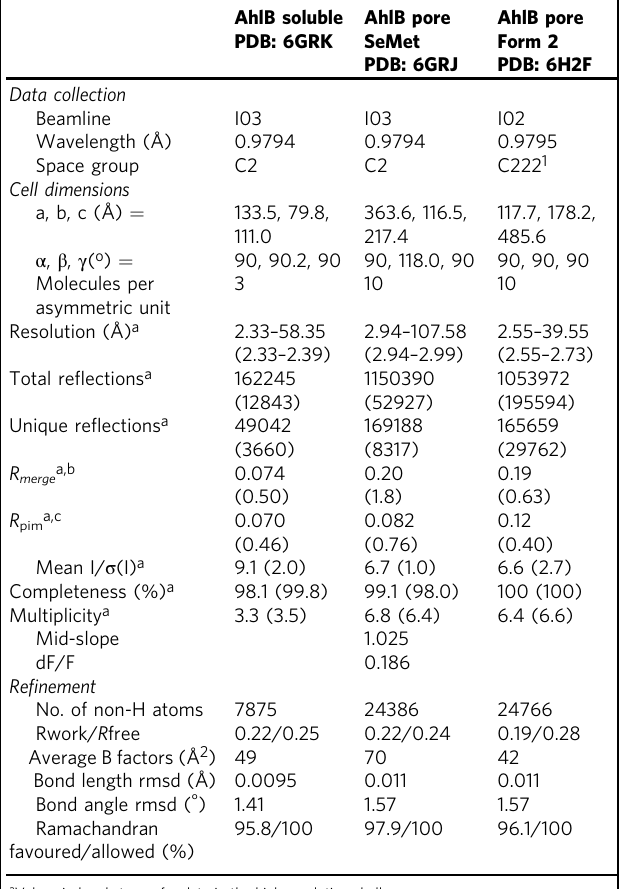
Table 1 X-ray data collection and re fi nement statistics for AhlB